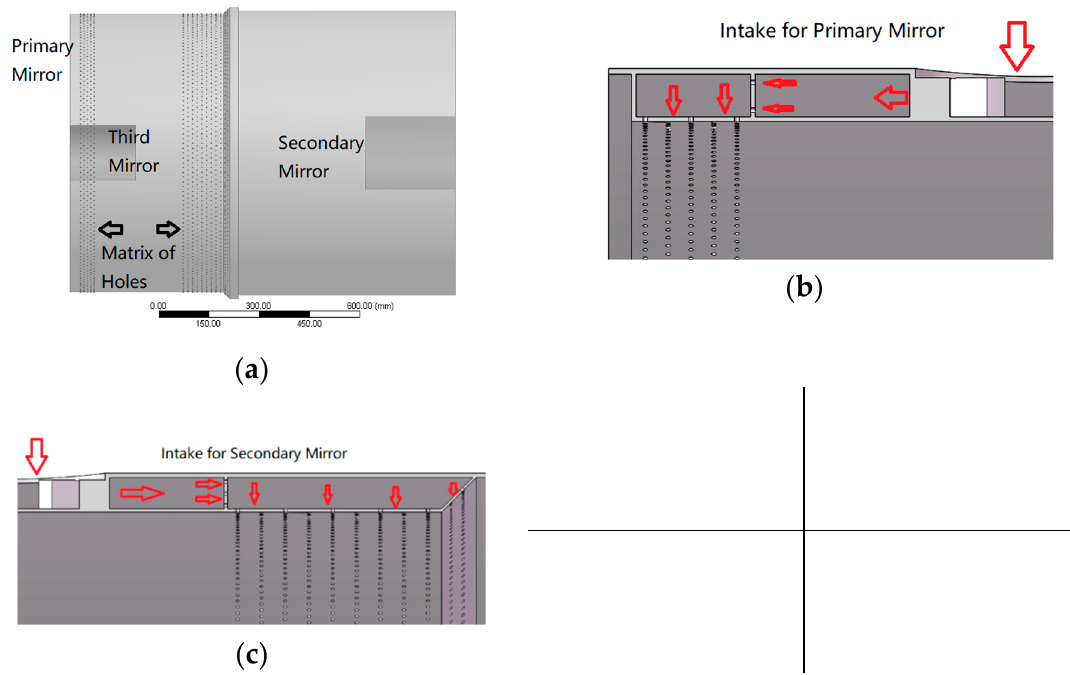
Figure 1. Schematic diagram of the beam expanding system: ( a ) the beam expanding system; ( b ) intake for primary mirror; ( c ) intake for second mirror.